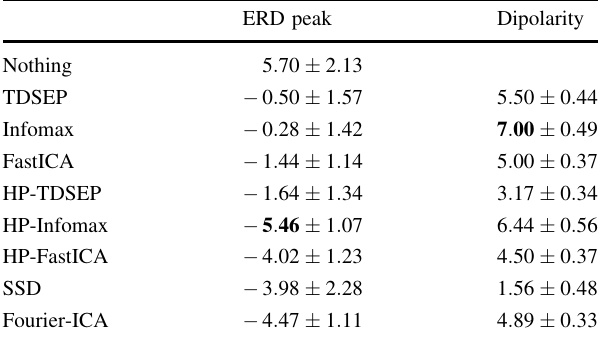
The best-performing method is highlighted in bold